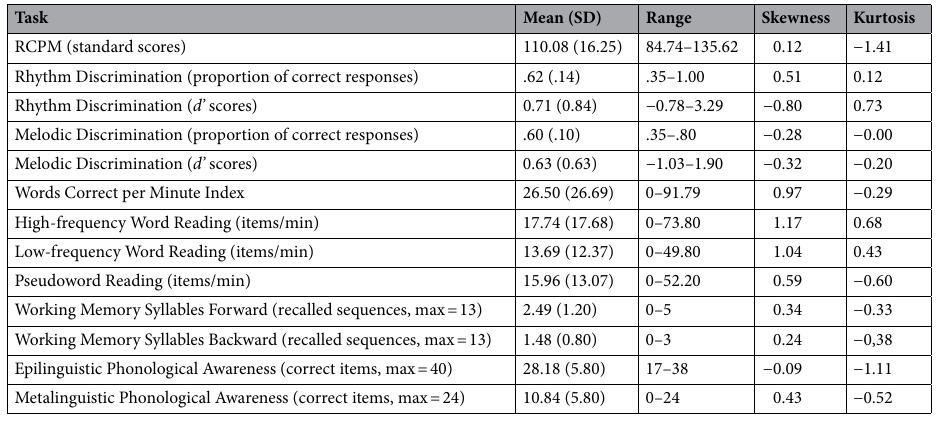
Table 1. Children’s cognitive ability and performance in rhythmic and melodic discrimination, reading, and speech-related tasks. N = 74 for all analyses, except for syllable working memory (forward and backward) where n = 73 due to a missing value. RCPM Raven’s Coloured Progressive